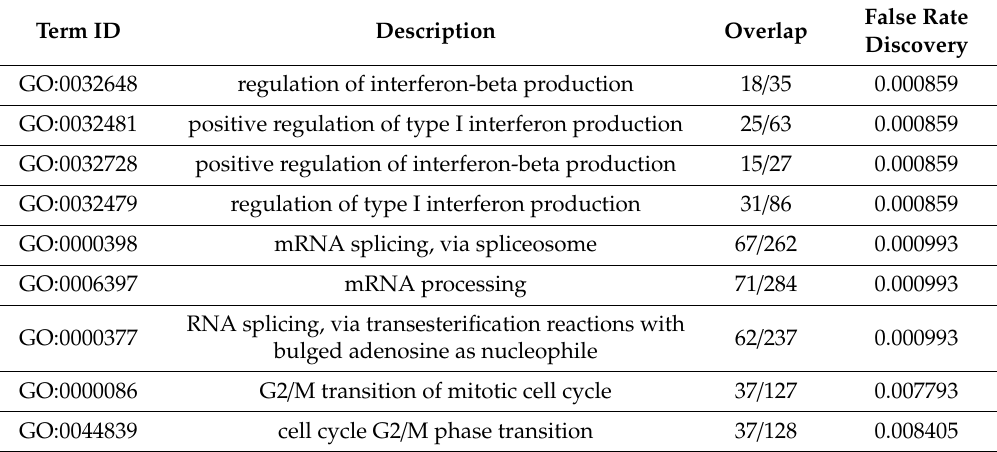
Table 1. GO biological processes terms. Enrichment analysis was performed using di ff erentially expressed genes in treated vs. untreated 4T1 cells. Overlap signifies input genes that matched genes in GO term vs. total genes listed in GO